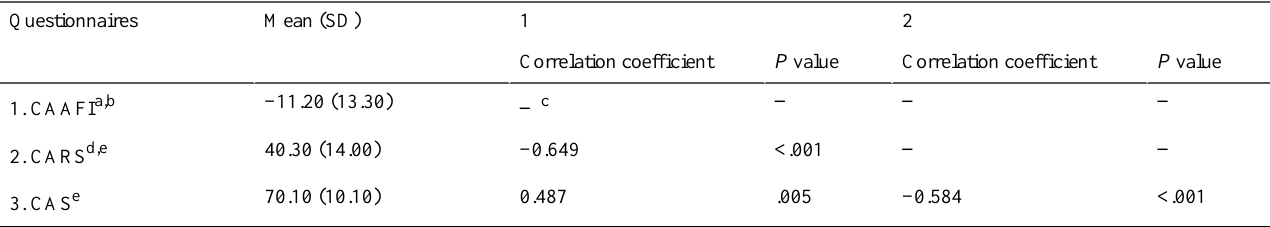
Table 3. Pearson correlations among